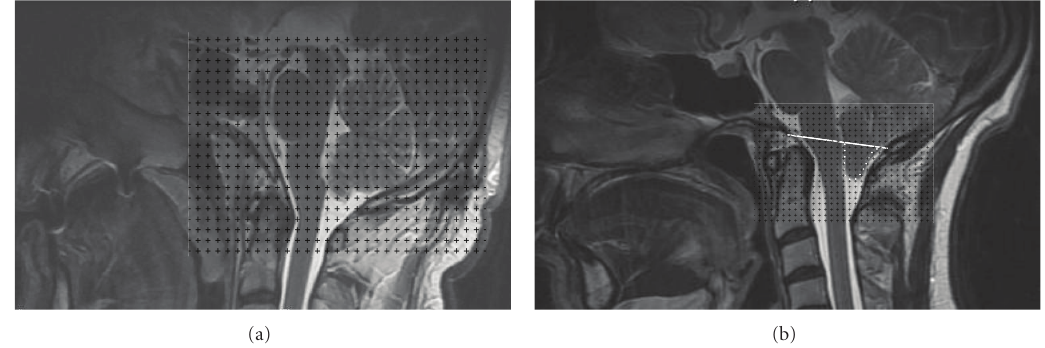
Figure 2: Representative midsagittal MRI for the cranial fossa and cerebellum (a) and herniated tonsils (b) with a grid overlaid for the calculation of volumes using the Cavalieri method.